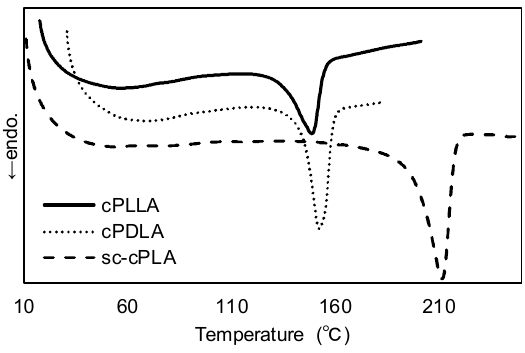
Figure 2. DSC measurements of the stereocomplex of c PLA (Table 2, entry 1).